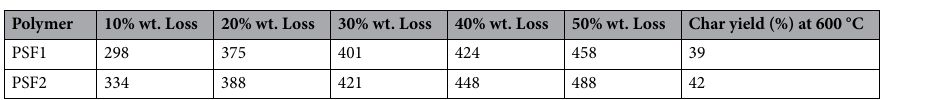
Table 1. Temperature (°C) for various decomposition levels in N 2 at a heating rate of 10 °C/min.